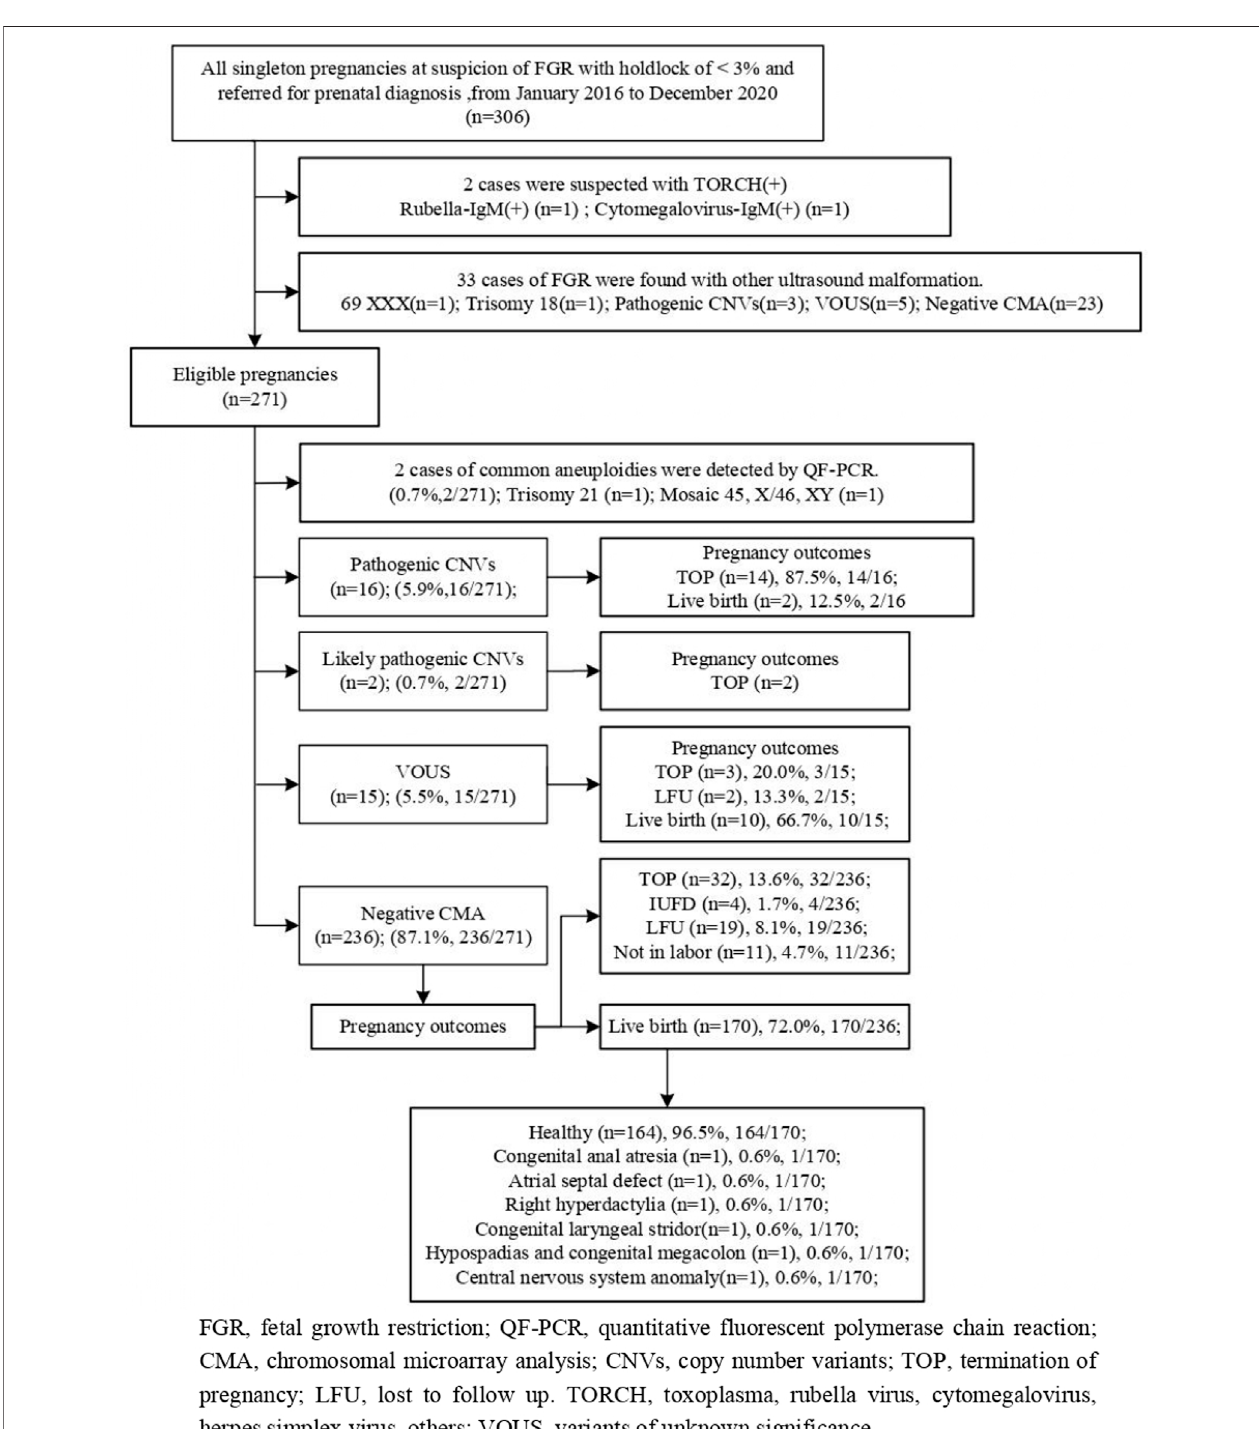
FIGURE 1 | Flowchart of this